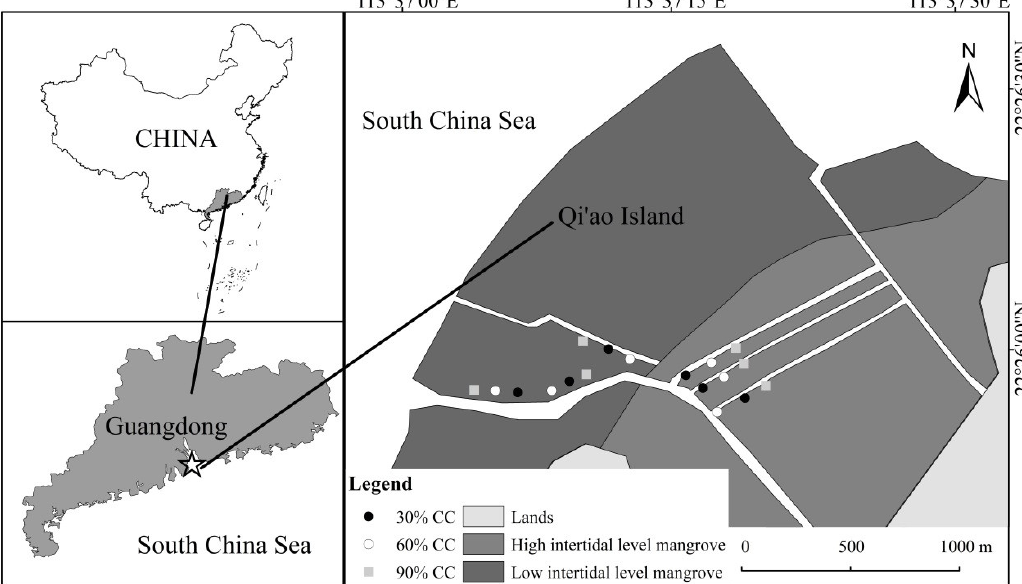
Figure 1. Sketch map of field trial sites in mangrove plantation at the Qi’ao Island. The abbreviations of sites refer to 30% canopy closure (30% CC), 60% canopy closure (60% CC) and 90% canopy closure (90% CC), respectively.